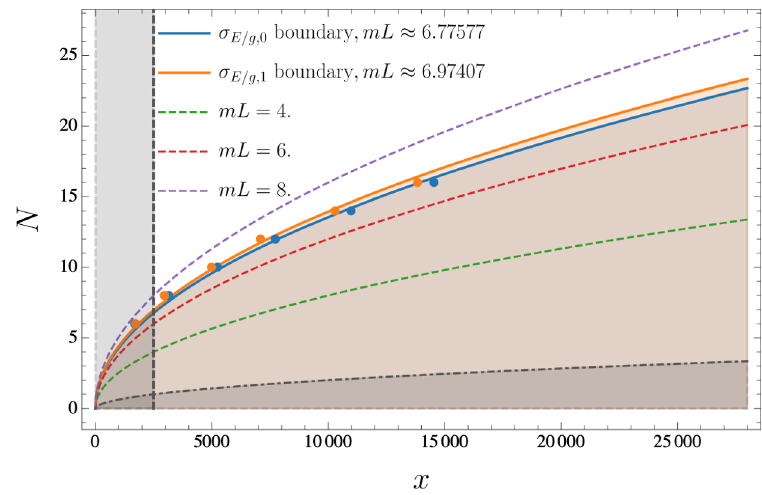
= 50 . Figure 12. The boundary separating the double-well regime and the multiwell regime for m g The boundaries x derived from σ and σ on the lattices of N = 6 , 8 , 10 , 12 , 14 , 16 bdy E/g, 0 E/g, 1 sites are shown as blue and orange dots respectively. Blue and orange solid curves are the fitting curves (4.24) of σ and σ respectively. The boundary in terms of the physical space size, E/g, 0 E/g, 1 . The white region above the fitting curves mL bdy , is derived from the fitting parameter A = mL bdy m/g is the double well regime while the orange/brown region below the fitting curves is the multiwell regime. The gray shaded rectangular region ( x < ( m/g ) 2 ) is ruled out due to the violation of eq. (2.21). The gray shaded region in the bottom ( x > ( N · m/g ) 2 , i.e. mL < 1 ), which is beyond the semiclassical regime, requires much larger l to explore and is not presented in this max